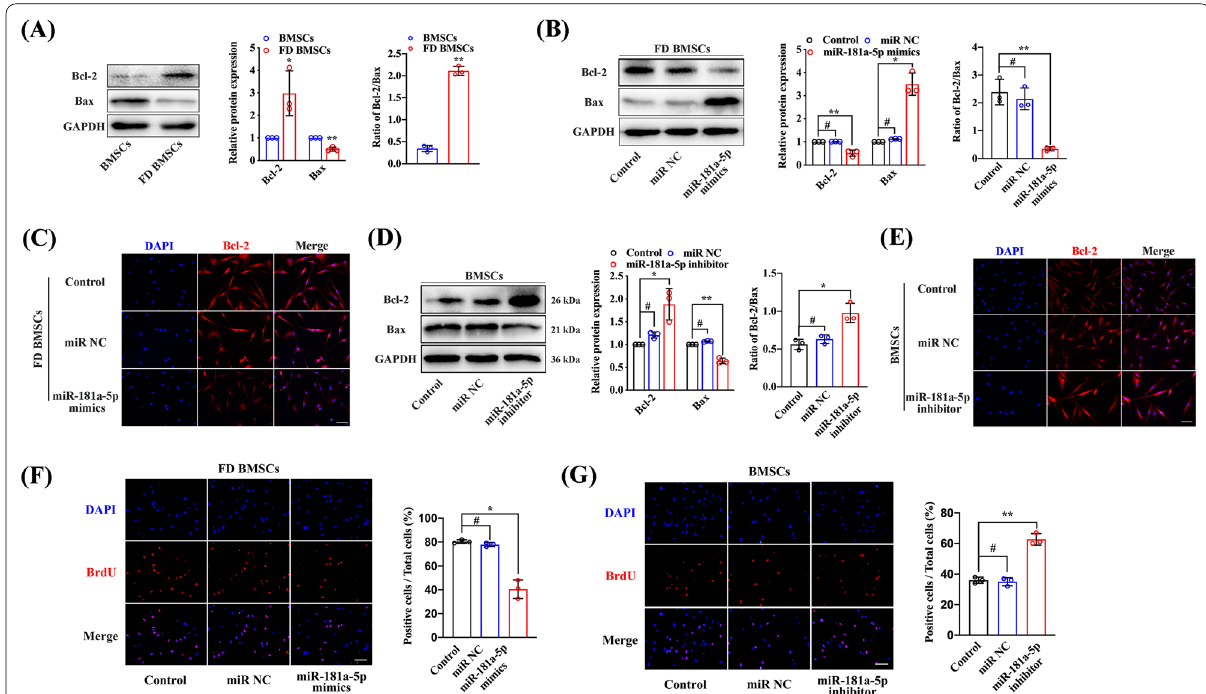
Fig. 2 Low miR-181a-5p expression suppresses the apoptosis and induces the proliferation of FD BMSCs. a Protein expression of Bcl-2 and Bax in BMSCs and FD BMSCs was detected by western blot. b Western blot analysis of Bcl-2 and Bax in FD BMSCs transfected with miR-181a-5p mimics. c Immunofluorescence analysis of Bcl-2 expression in FD BMSCs transfected with miR-181a-5p mimics. d Western blot analysis of Bcl-2 and Bax in BMSCs transfected with the miR-181a-5p inhibitor. e Immunofluorescence analysis of Bcl-2 expression in BMSCs transfected with the miR-181a-5p inhibitor. Representative BrdU incorporation in FD BMSCs transfected with miR-181a-5p mimics ( f ) and BMSCs transfected with the miR-181a-5p inhibitor ( g ). Scale bar, 100 μm. The data are presented as the mean S.E.M. values (n 3). # P > 0.05; * P < 0.05; ** P < ± =